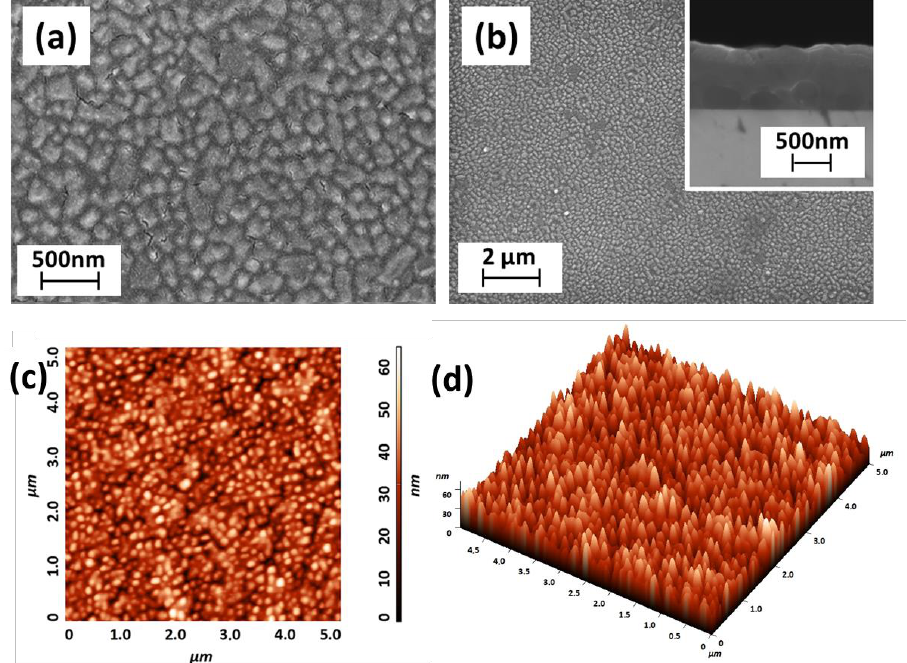
Figure 7. ( a , b ) FE-SEM images and ( c ) 2D and ( d ) 3D AFM topographical image (RMS roughness of 10.2 nm on 2.5 × 2.5 µm area) of BaCe 0.8 Y 0.2 O 3 thin film grown on the YSZ (100) substrate at a depo- sition temperature of 950 °C. Inset in ( a ) reports the cross-sectional image of the film.